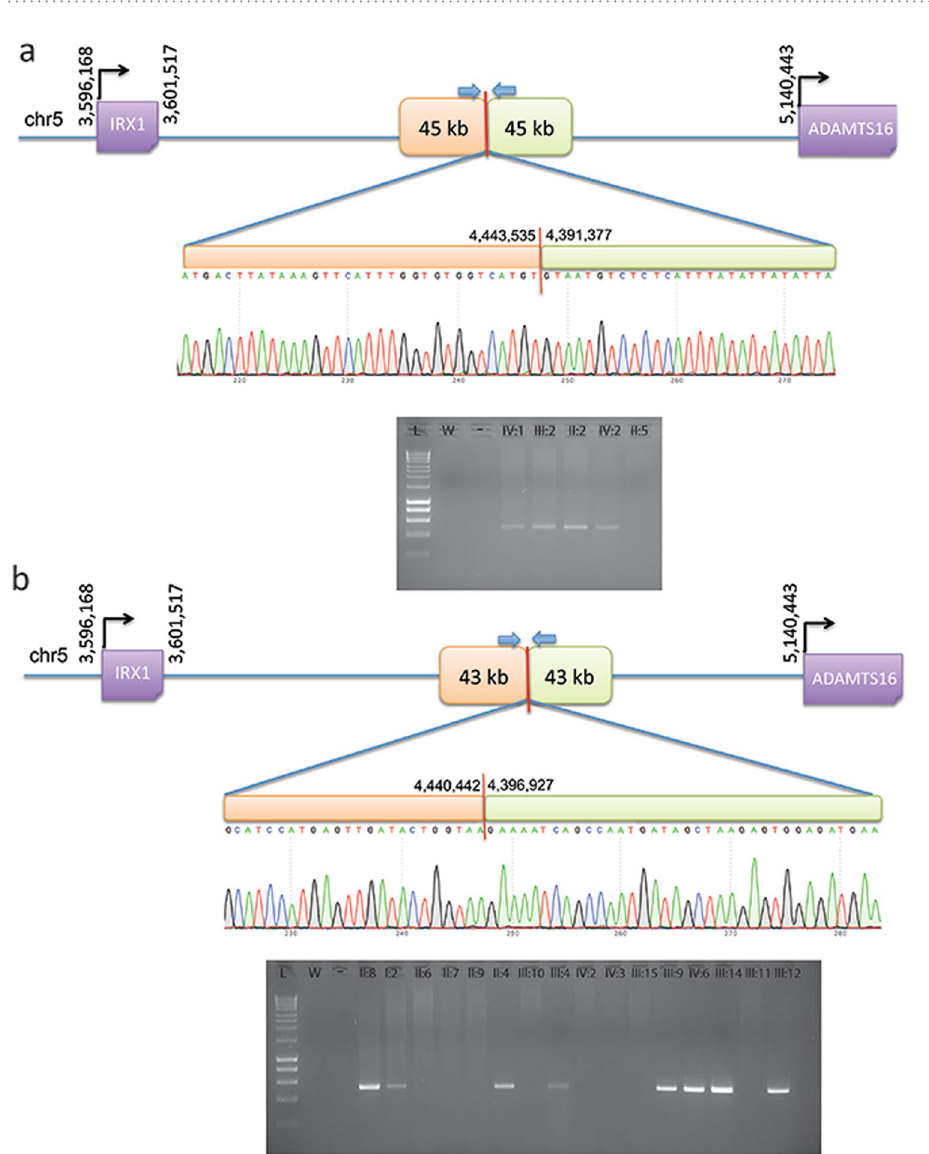
Figure 3. PCR and Sanger sequencing validation of duplication breakpoints and segregation in family 1 ( a ) and family 2 ( b ). All available individuals (Supplementary Fig. S1) were tested with primers designed across the predicted breakpoints to generate a unique junction fragment sequence. The exact breakpoint is marked with a red bar; PCR primers are represented with blue arrows. L = ladder; W = water; “-” = genomic DNA pooled from control